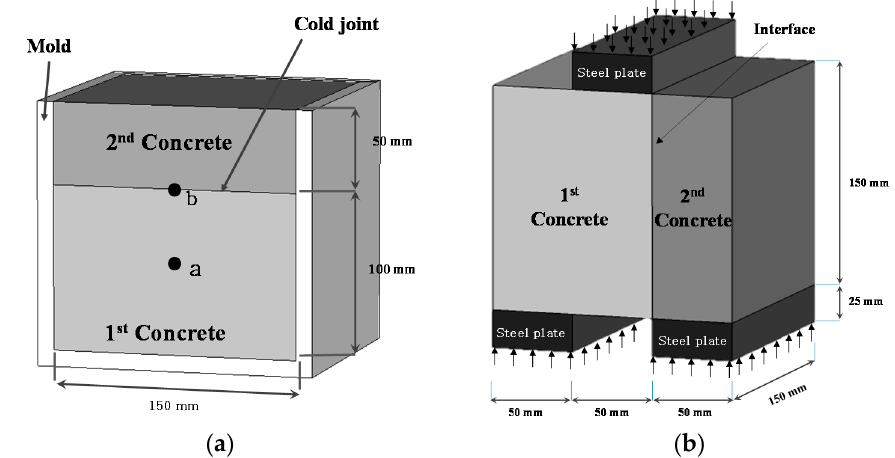
Figure 4. Overview of direct shear test: ( a ) locations of sample collection for microstructure analysis; and ( b ) direct shear test method and specimen size.